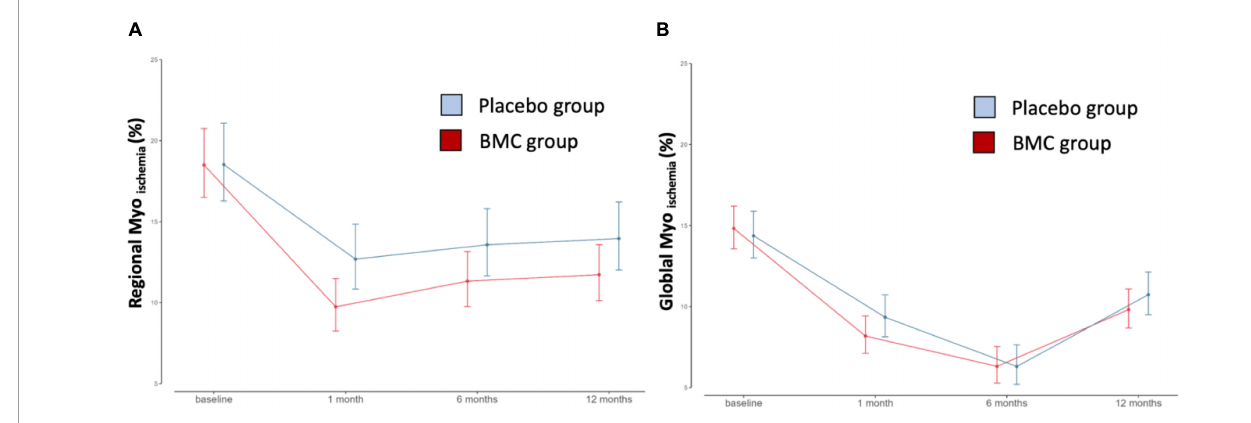
FIGURE2 Regional and global stress-induced myocardial ischemia (SIMI). (A) Regional stress-induced ischemia ( P -value = 0.047); (B) global stress-induced ischemia in different time points after CABG in patients receiving BMC vs. placebo group ( P -value = 0.491).